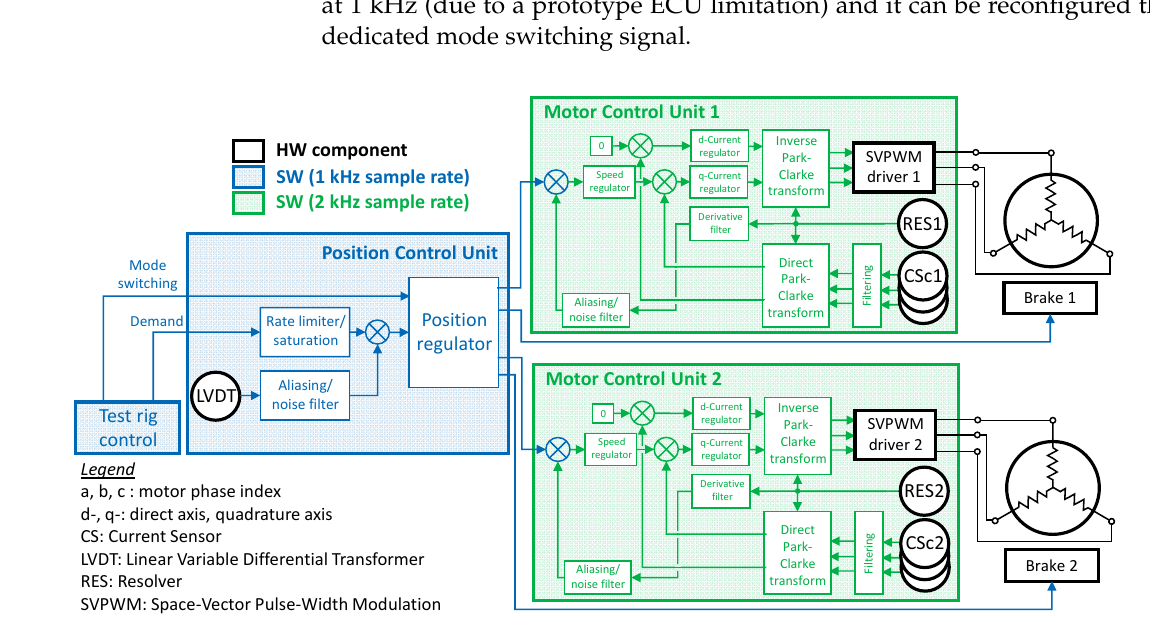
Figure 5. Simplex ECU prototype for the experimental validation of the EMA model.